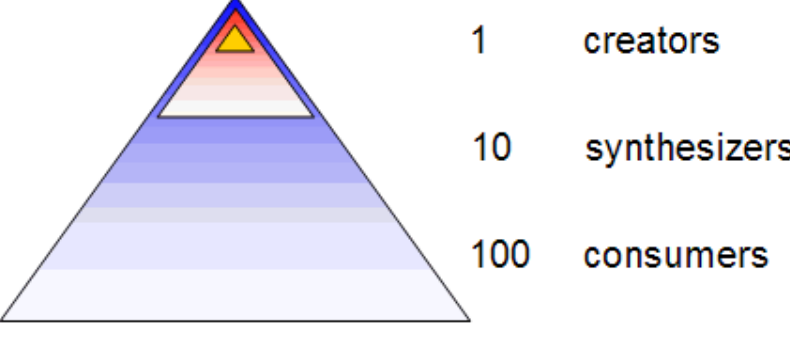
Figure 2: Bradley Horowitz’s Social Media